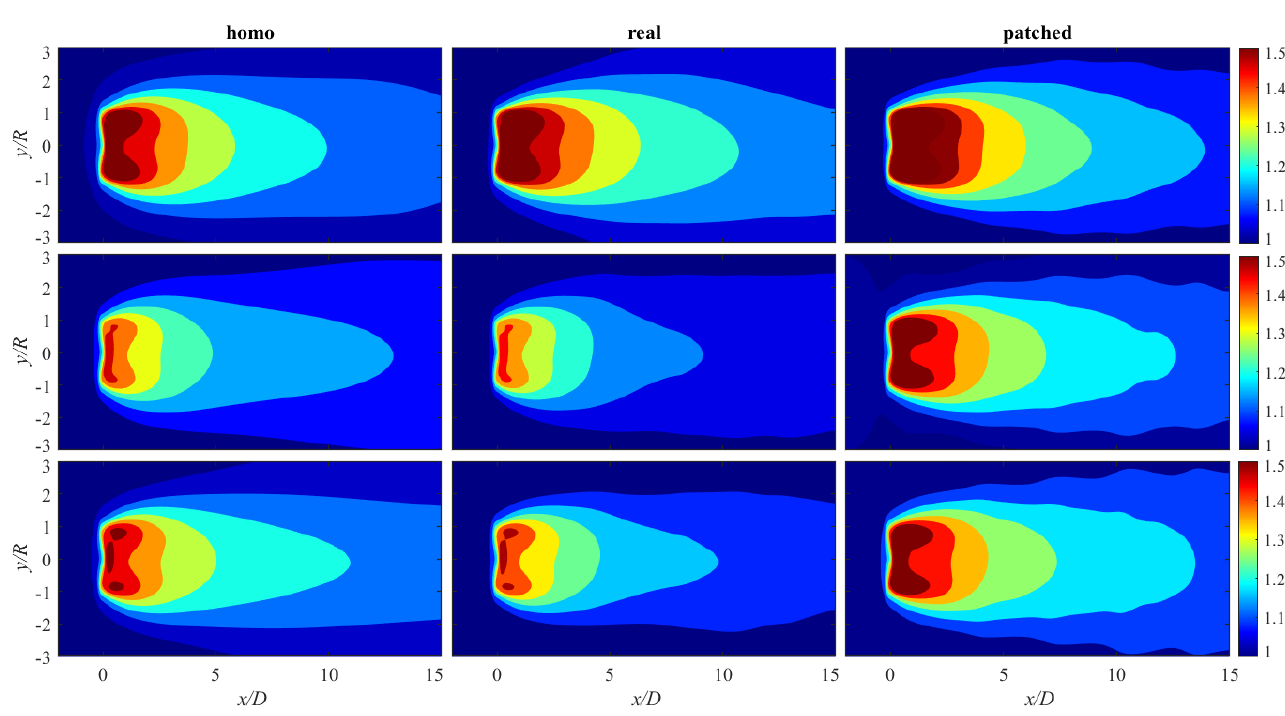
Figure 24. Mean TKE contours from horizontal (X-Y) planes at the hub height. Row-wise, LAI =